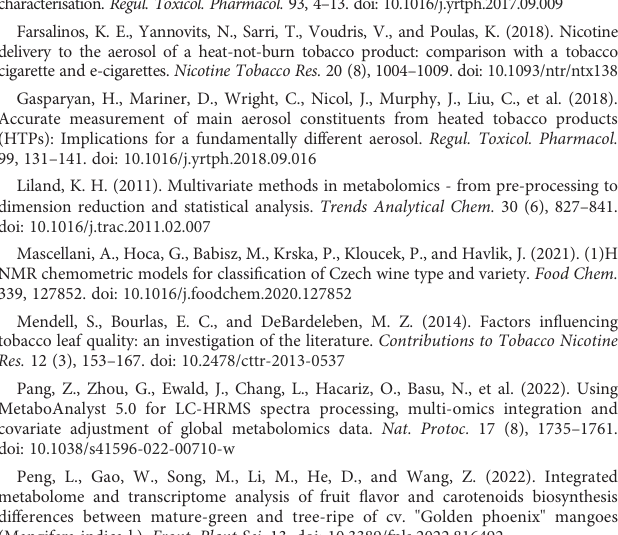
SUPPLEMENTARY TABLE 2 Non-volatile metabolites detected by